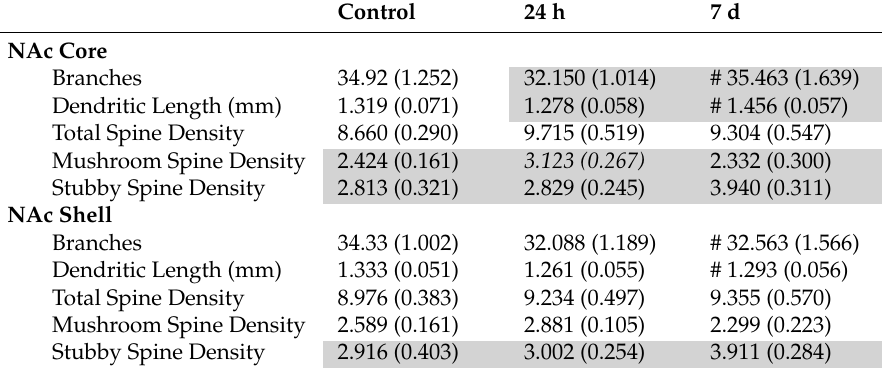
Table A1. Mean (SEM) branches, dendritic length, and spine density (spines / 10 µ m; total, mushroom, and stubby spines) in the nucleus accumbens (NAc) core and shell for the control, 24 h, and 7 d groups from [1]. Grey shaded means indicate significant post-hoc comparisons ( p < 0.05). For stubby spines in each region the 7 d group had significantly greater means than the control and 24 h groups. For mushroom spines in the core the 24 h group had values greater than the control and 7 d groups. # shown for 7 d branching and length values indicate a significant post-hoc di ff erence between regions (Core >